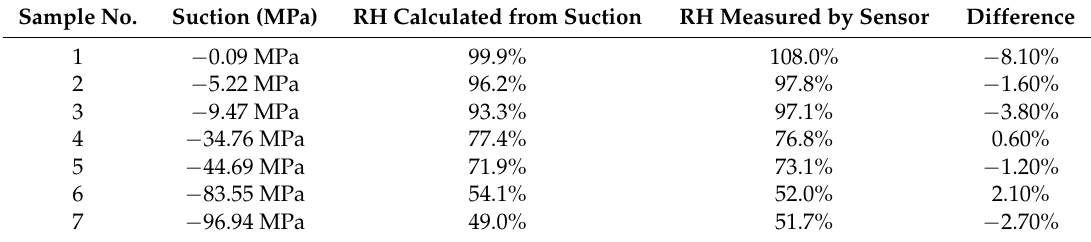
Table 1. RH for seven hydrated bentonite samples from Experiment 2, measured by the psychrometer and by the